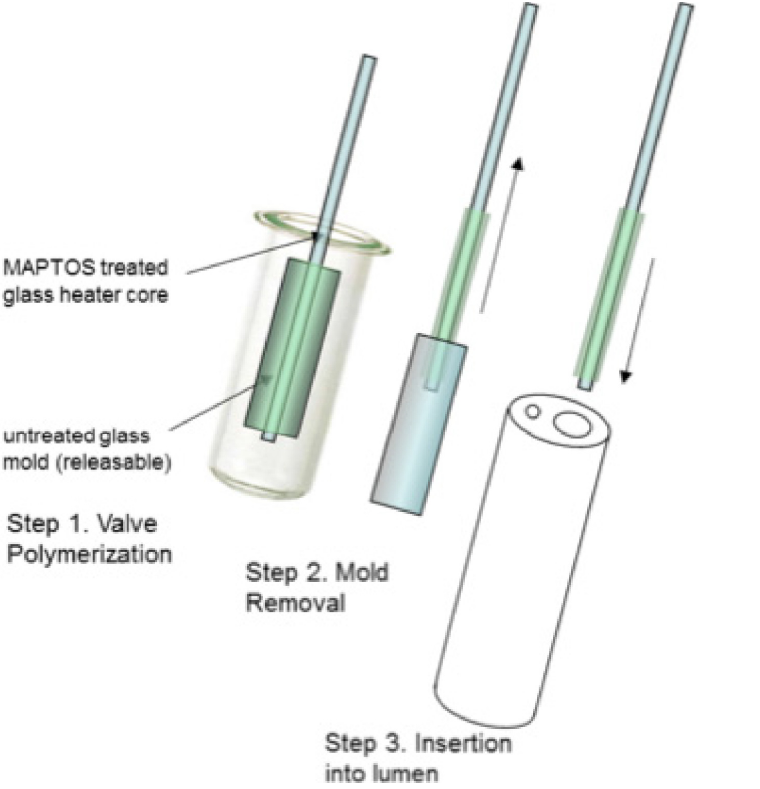
Fig 2. Fabrication steps of the thermally actuated polymeric